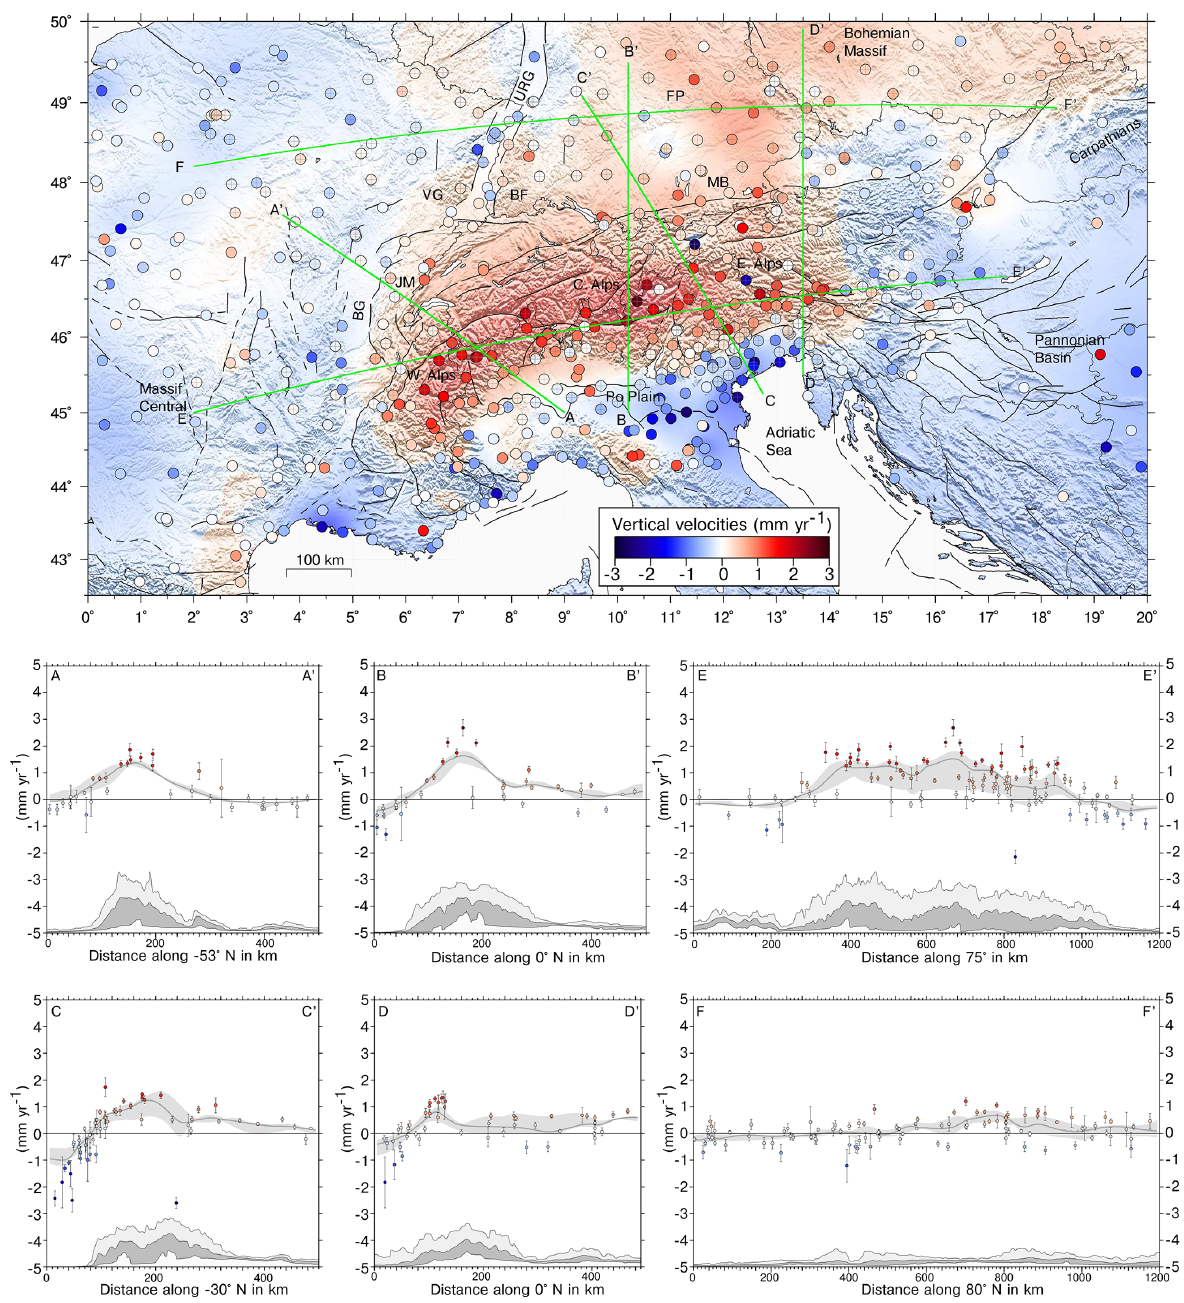
Figure 17. Vertical velocities from filtered time series (colored circles), a continuous velocity field, and topographic and swath profiles across the greater Alpine area. Each profile (green line) encompasses a 50 + 50km swath. BG stands for Bresse Graben, JM stands for Jura Mountains, VG stands for Vosges Mountains, BF stands for Black Forest, URG stands for Upper Rhine Graben, FP stands for Franconian Platform, and MB stands for Molasse